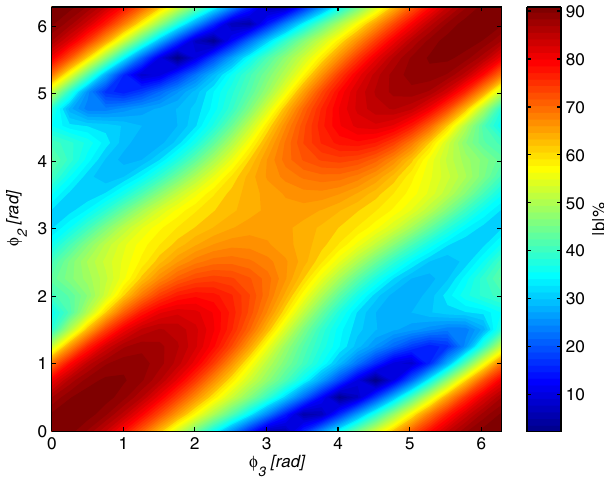
FIG. 14. Tolerance of adiabatic buncher to phase jitter in second and third lasers.